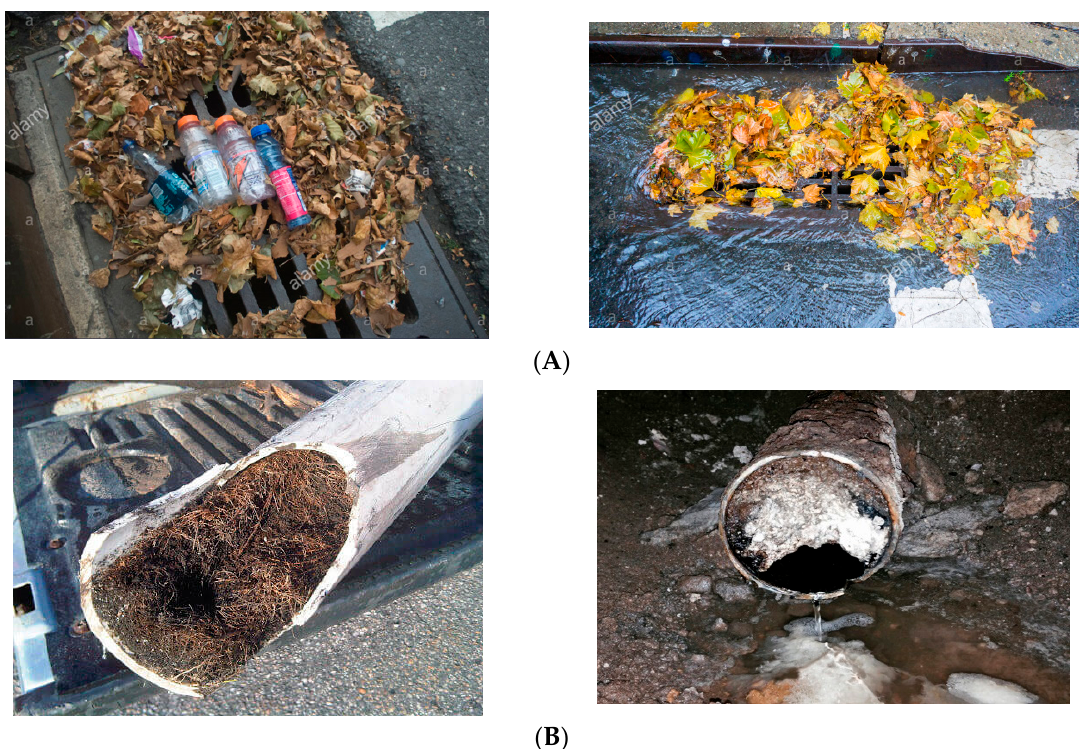
Figure 1. Di ff erent ratios of blockage. ( A ) blockage through grate cover ( B ) blockage through storm pipes https: // www.alamy.com / stock-photo / blocked-drain.html